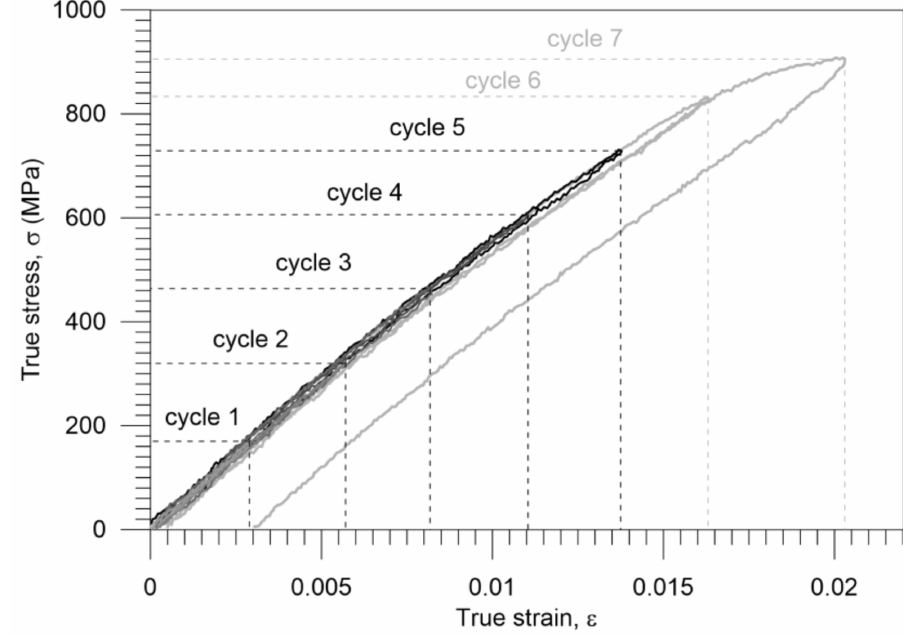
Figure 5. Stress versus strain for Gum Metal during incremental cyclic loading–unloading at a strain rate of 10 − 2 s − 1 calculated from the DIC virtual extensometer; step 0.0025 for cycles 1–6 and 0.005 for cycle 7. The stress σ and mean temperature changes ∆ T mean versus strain for the initial stage of tension at strain rates of 10 − 2 s − 1 and 10 − 1 s − 1 are shown in Figure 6a,b, respectively. In the same figures, strain distributions in the direction of tension ε y obtained by the DIC algorithm and temperature distributions obtained by IRT are presented. The thermogram marked by 0 denotes the temperature distribution before specimen loading. The marked points A*-A, B*-B, and C*-C denote the stress and temperature values corresponding to the Gum Metal’s elastic limit (maximal drop in temperature), the limit of the mechanically reversible deformation, and the start of almost linear, significantly higher increase in temperature, respectively (Figure